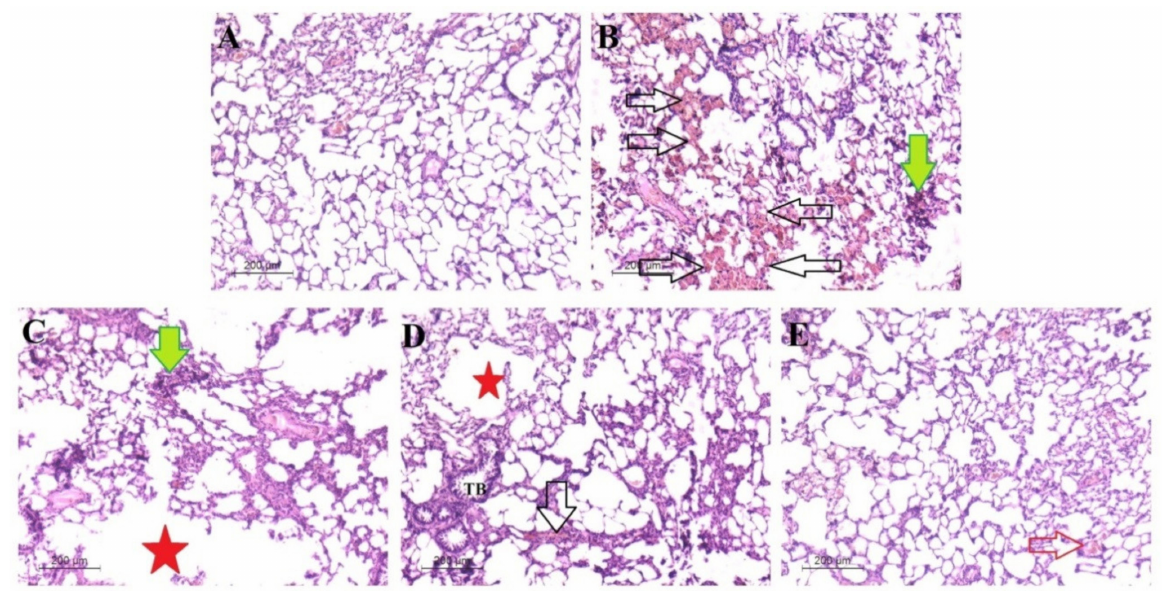
Figure 13. Photomicrograph of rat lung infected with Kp5 and given endotracheal aerosolization various preparations of 1,2,3-triazole-sulphadiazine-ZnO hybrids as treatments, 48 h post-infection. ( A ) Negative control group. ( B ) Positive control; ( C ) 3c -ZnO; ( D ) 3a -ZnO; and ( E ) 3b -ZnO. In which black arrows refer to focal accumulations of macrophages (in B ); red arrows refer to normal small blood vessels for gas exchange; red stars (alveolar histiocytosis); green arrows refer to densely packed cluster of lymphocytes associated lymphoid tissue; TB refers to terminal bronchioles found to be alienated with normal histological structure in ( D ) and damaged ones observed in ( C ). H&E stain (magnification: 200 ×